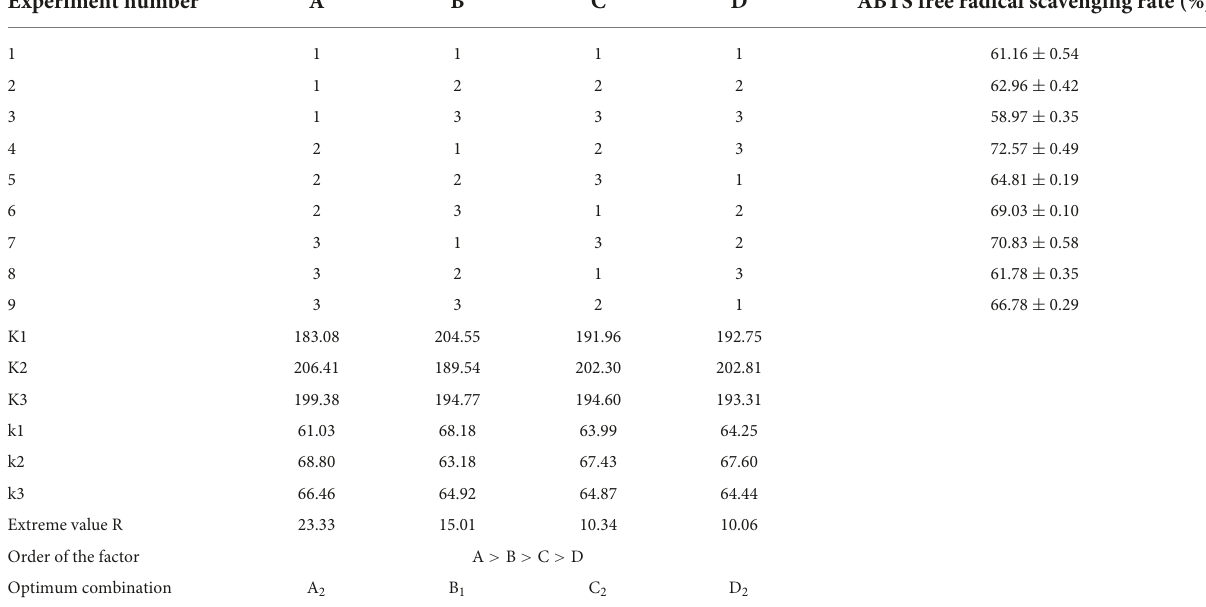
TABLE 2 Orthogonal experimental analysis.